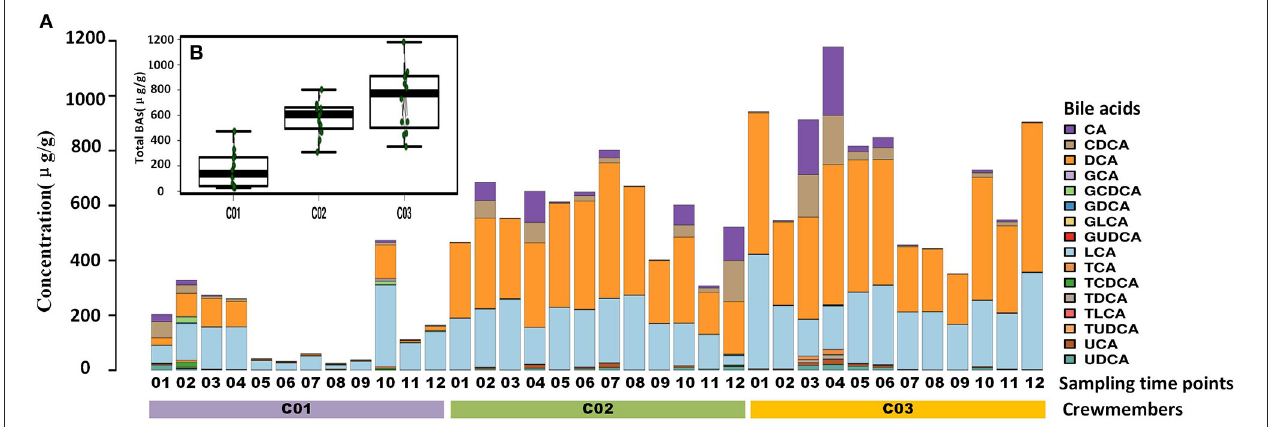
FIGURE 1 | Profiling of fecal bile acids (BAs) of the three crewmembers. (A) Longitude variation of fecal BAs of the three crewmembers (C01, C02, and C03 refers to the three crewmembers, sequenced numbers 01–12 refers to different sampling time pionts). (B) Comparison of total BAs from fecal samples from the three